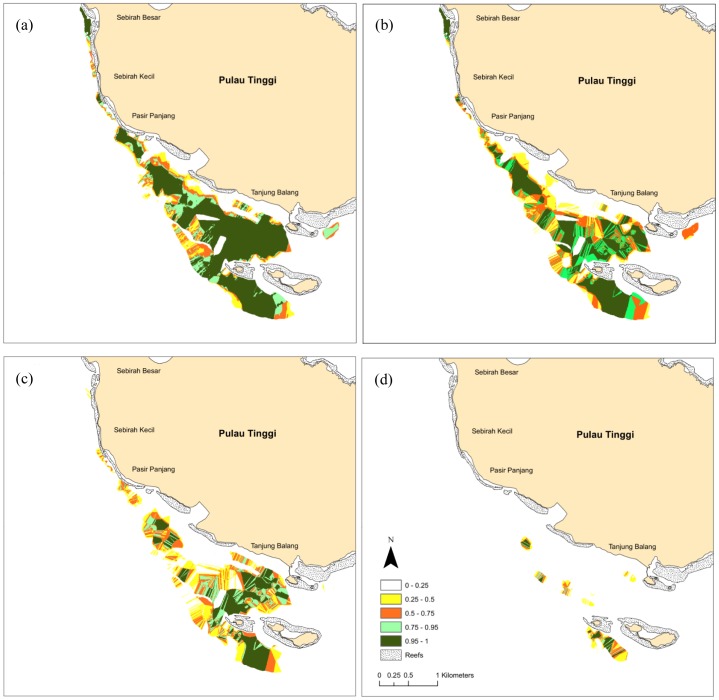
Probability estimates for the occurrence of (a) Halophila spp.(b) Halodule uninervis (c) Cymodocea serrulata, and (d) Syringodium isoetifolium in the southwest of Pulau Tinggi, Malaysia, produced by ordinary kriging in 5 m cells.